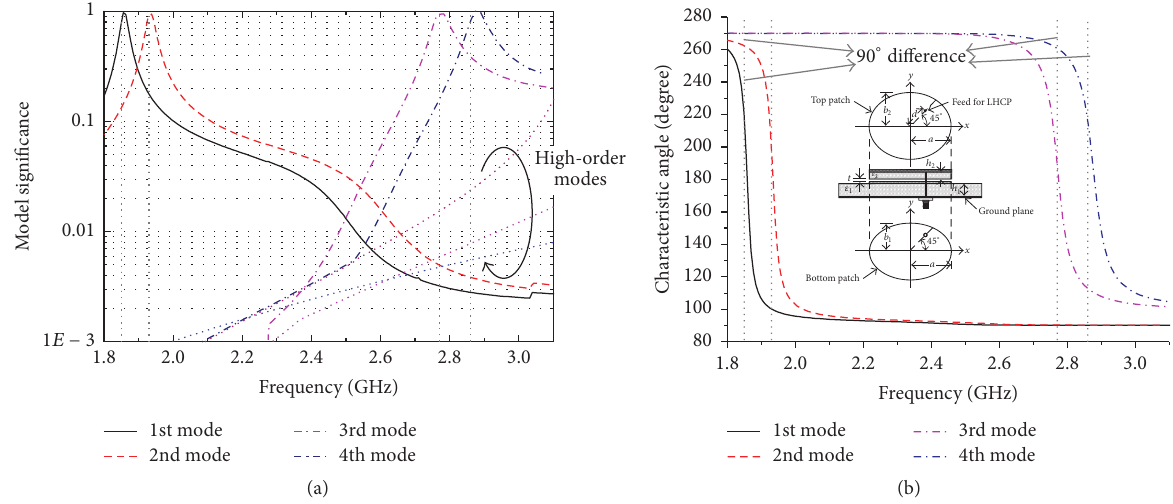
Figure 4: Modal significances (a) and characteristic angles (b) for the dual-band CP antenna. 𝜀 1 = 𝜀 2 = 4.4 , ℎ 1 = 1.6 mm, ℎ 2 = 0.8 mm, /𝑎 = 0.95 , and 𝑏 /𝑎 = 0.96 . The grayed dash lines indicate the frequency at which the characteristic angle 𝑡 = 0.5 mm, 𝑎 = 21.86 mm, 𝑏 1 2 differences exactly equal 90 ∘ .